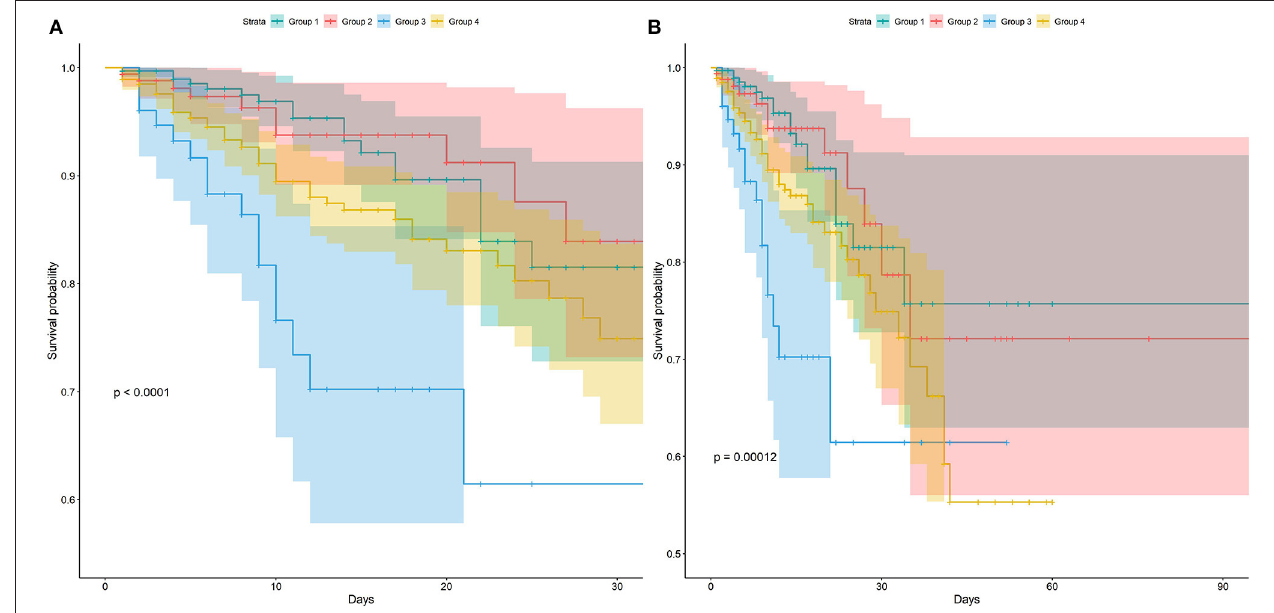
FIGURE 2 | Kaplan-Meier survival curves between groups. P -value calculated by Log-rank test = 0.012 showed Group 3 had lower survival probability. (A) Represented the survival probability in 30-day. (B) Represented the survival probability in 90-day.